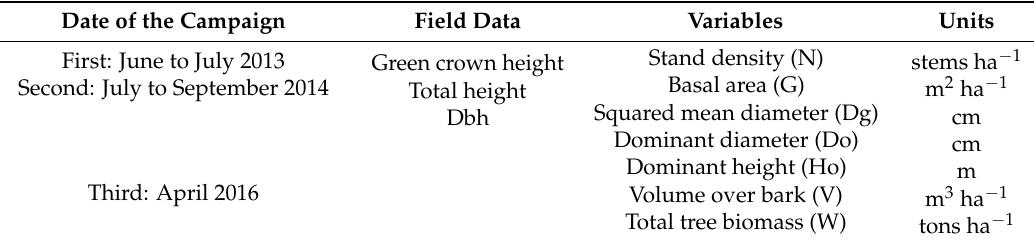
Table 1. Forest inventory attributes.